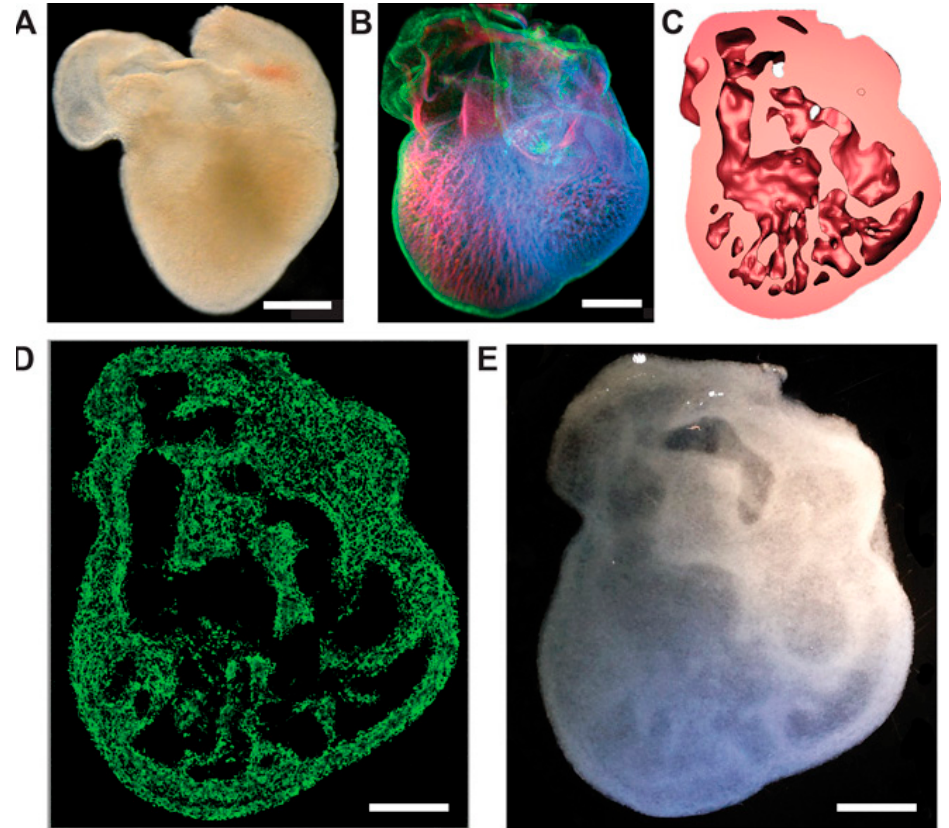
Figure 3. Method to bioprint a trabeculated embryonic heart using alginate-based bioinks. ( A ) Optical microscopy image of an embryonic chick heart; ( B ) a confocal microscopy 3D image of an embryonic chick heart stained for fibronectin (green), nuclei (blue), and F-actin (red); ( C ) a cross-section of the 3D model of the heart based on the confocal imaging data; ( D ) a cross-section of the 3D-printed heart in fluorescent alginate (green); ( E ) optical microscopy image of the bioprinted trabeculated embryonic heart. Figure modified from [55]. Scale bars, 1 mm ( A and B ) and 1 cm ( D and E ).